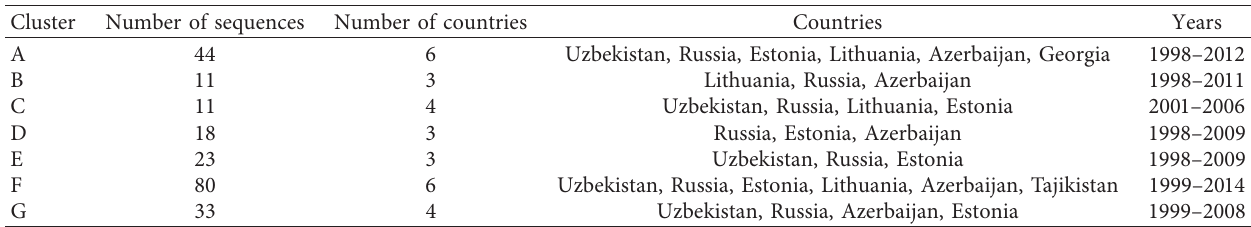
Table 2: Cluster analysis of HCV 3a NS5B tree in Figure 2 showing distribution of sequences among FSU countries. Cluster Number of sequences Number of